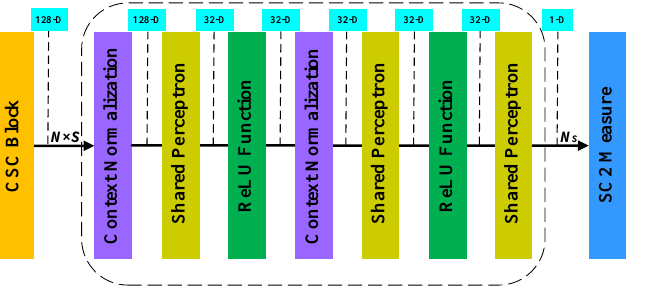
Figure 6. Seed Selection. It mainly consists of two similar sequences Context Norm layer, Shared Perceptron layer, and ReLU layer. Finally, it goes through a shared perceptron to reduce the dimen- sionality